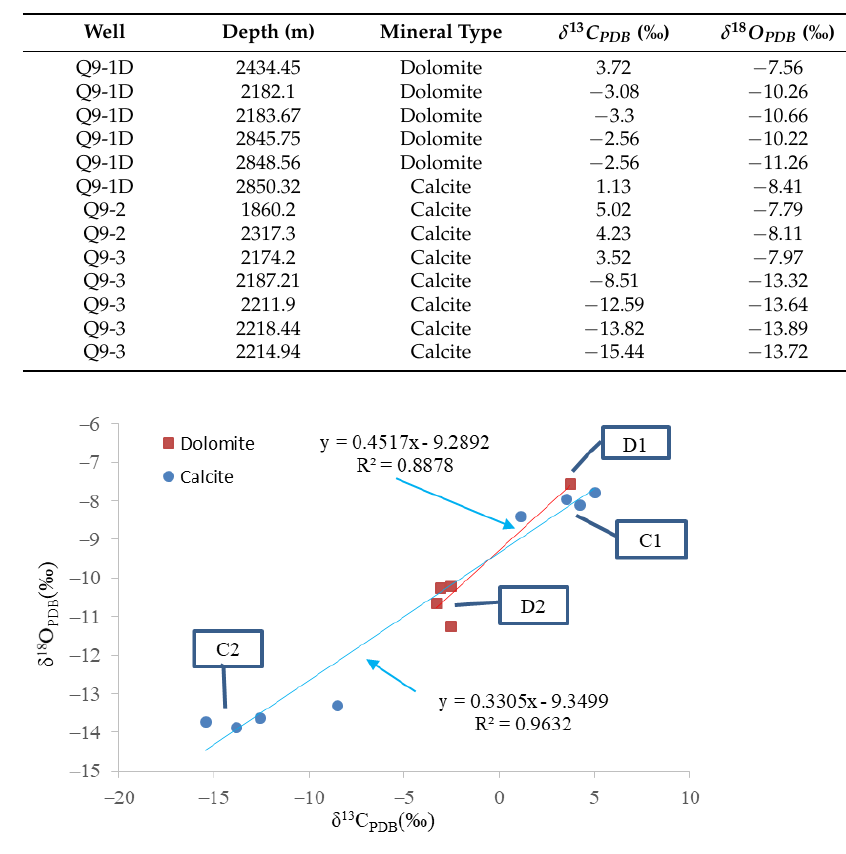
Table 2. The micro isotopic data of carbonate minerals in the study area.